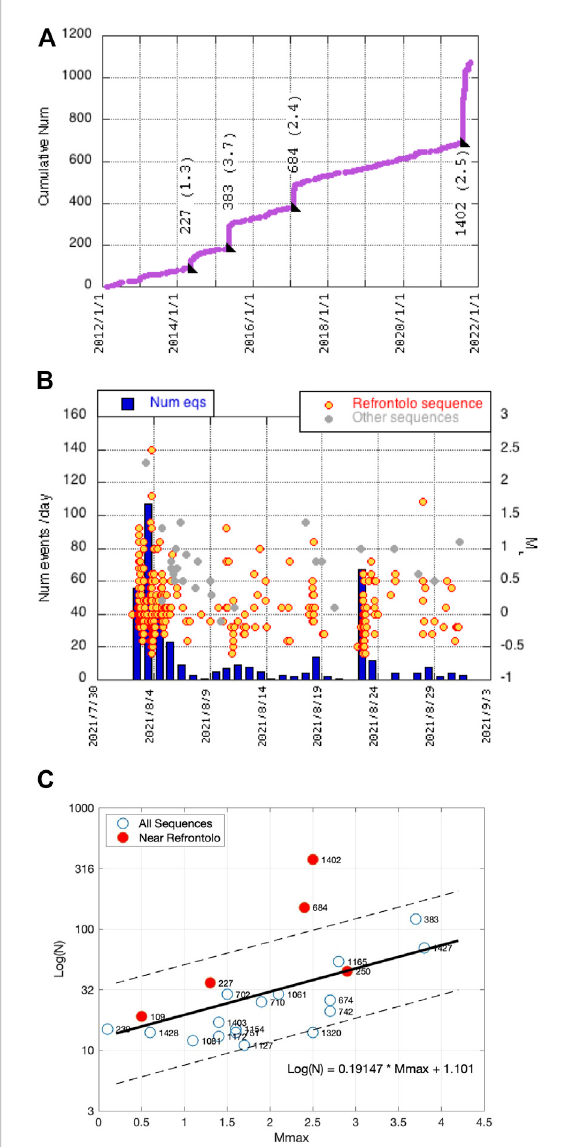
FIGURE 2 Seismicity detected by the RSC network. (A) Cumulative number of events located by the RSC in Area A (see Figure 1) from January 2012 to October 2021; the jumps correspond to sequences, the vertical labels indicate the cluster identi fi er and maximum magnitude (in brackets) — see Supplementary Material. (B) Daily number of events (left axis, blue bars) and magnitude (right axis, circles) as afunction of time for earthquakes located by the RSC in August 2021. Events belonging to the Refrontolo sequence are indicated by red/yellow circles, in gray the events occurred elsewhere but inside the area shown in Figure 1. (C) Global number of events versus Mmax for the most populated clusters identi fi ed by the RSC (see Supplementary Material; Supplementary Figure S1; Supplementary Table S1). The labels indicate the clusters ID, the red dots are the sequences closest to that of Refrontolo 2021. The thick solid and thin dashed lines represent the linear regression (formula in the fi gure) and the 5th and 95th percentiles (2 sigma), respectively. The Refrontolo sequence is the cluster ID